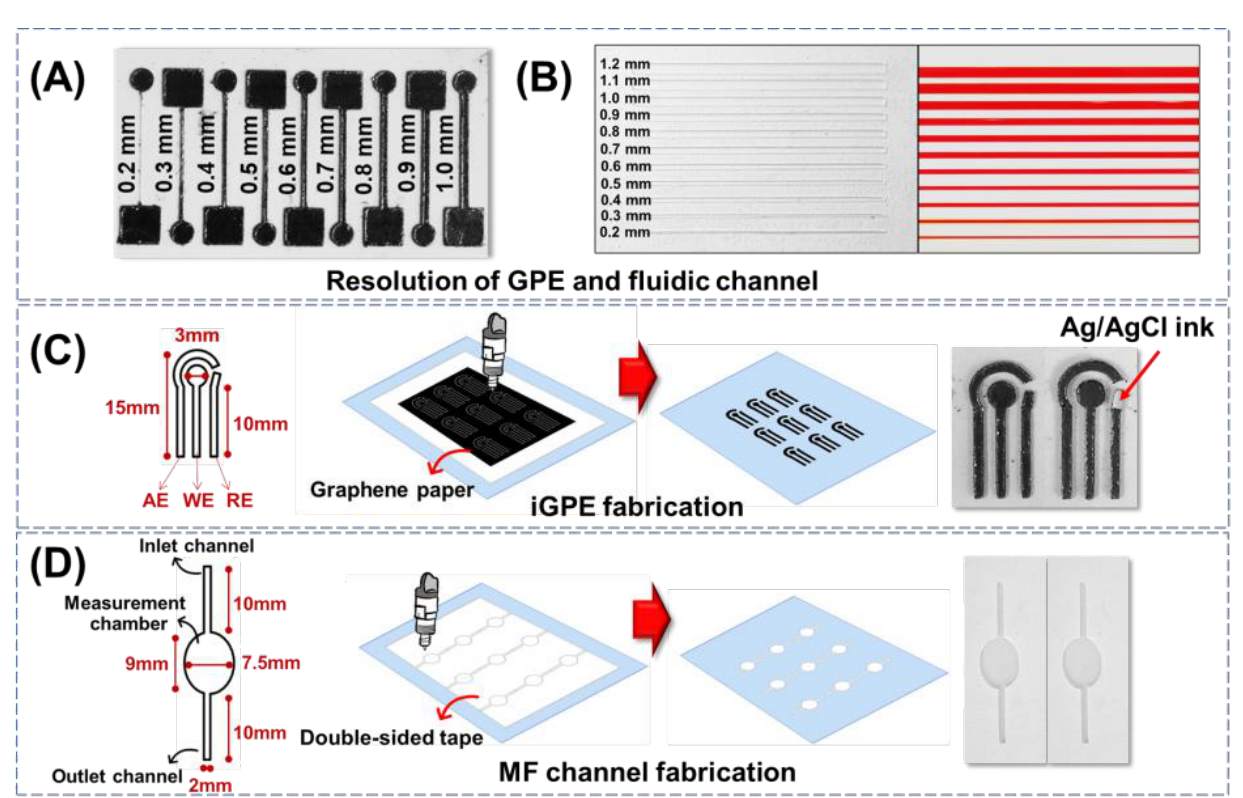
Figure 1. ( A ) Resolution of graphene paper conductive tracks fabricated via xurography. ( B ) Resolution of fluidic channels fabricated via xurography. ( C ) The design and fabrication of the iGPE module consisted of AE: auxiliary electrode, WE: working electrode, and RE: reference electrode.